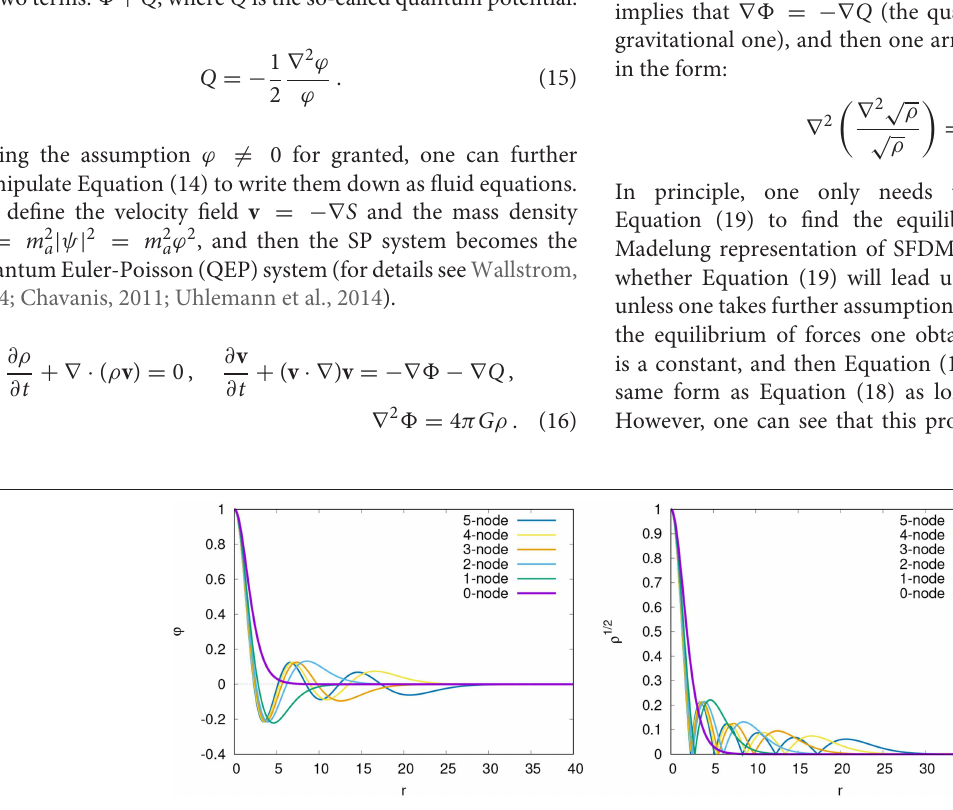
ϕ ( r ) (Left) and the square root of =